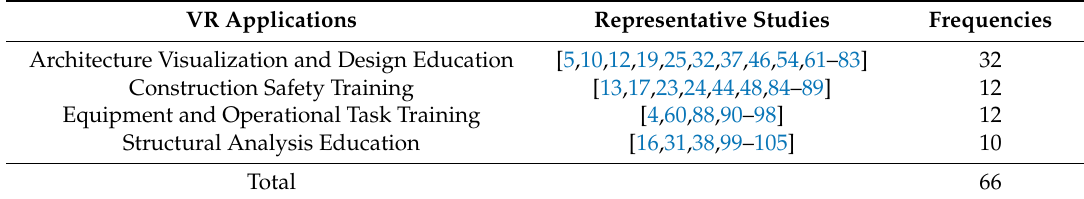
Table 4. The distribution of publications characterized by VR application in